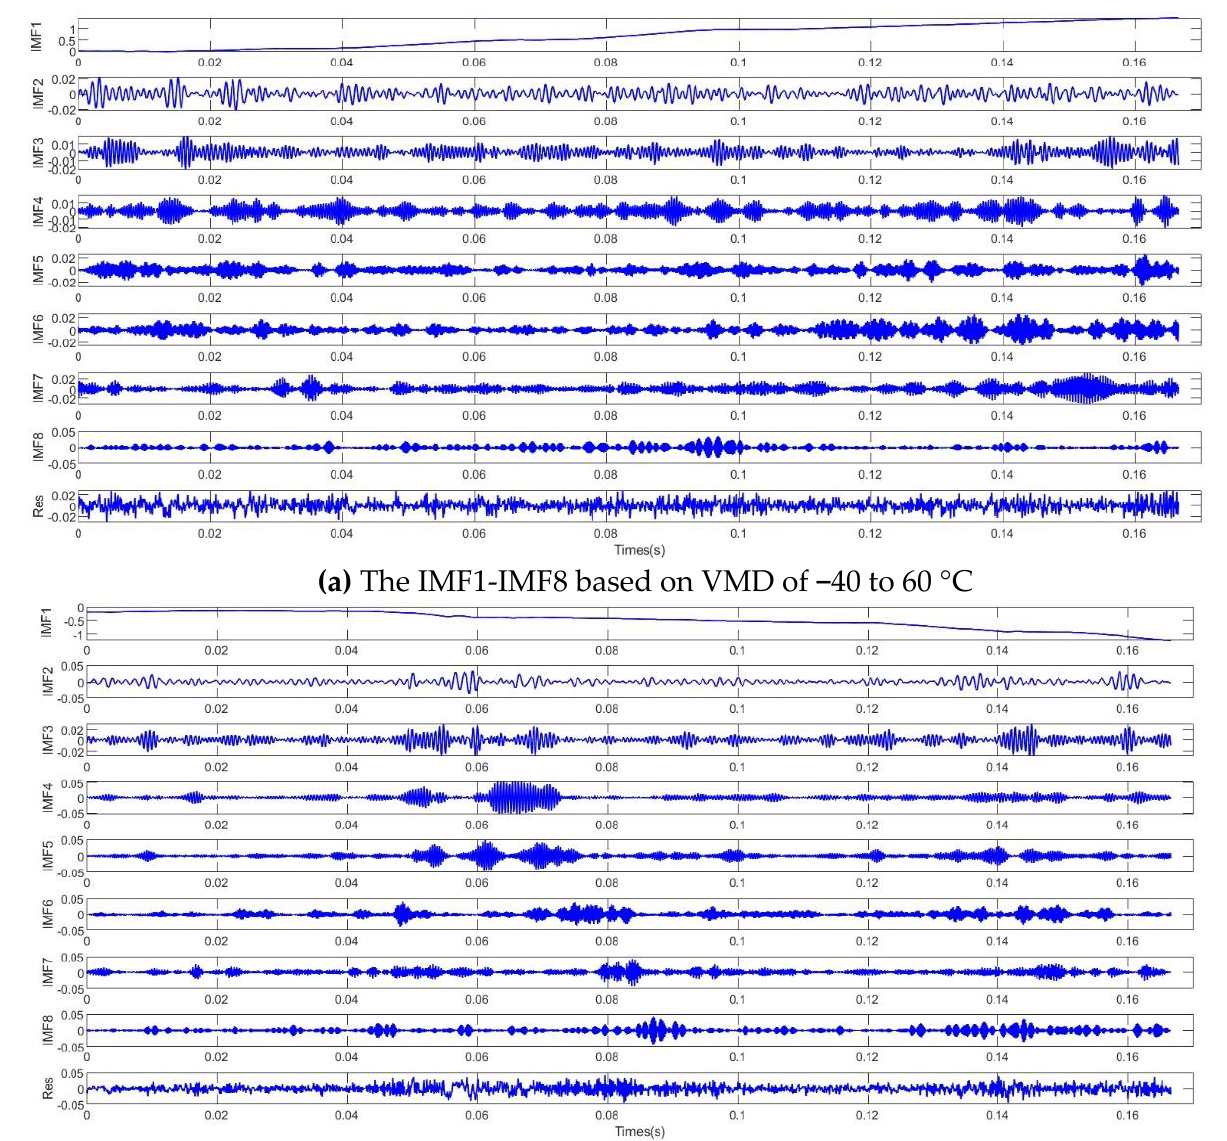
Figure 15. The IMF1-IMF8 based on VMD of ( a ) − 40 to 60 °C and ( b ) 60 to − 40 °C. If the sample entropy value of the IMF is greater than 0.6, it is a pure noise term that does not contain any useful signals, and it can be deleted directly. If the sample entropy value of the IMF is between 0.3 and 0.5, it is intermediate-frequency temperature noise, which also includes effective temperature characteristics and noise signals. The PSO-SVM method is used to deal with this part of the noise, because it is the most important part of the temperature compensation model. If the signal sample entropy value is between 0.2 and 0.3, the signal is a low-frequency noise signal, using CNN-LSTM to build the compensation model. The specific classification of high-frequency noise signal η high ( t ) , intermediate-frequency temperature noise signal η medium ( t ) and low-frequency noise signal η low ( t ) is shown in Figure